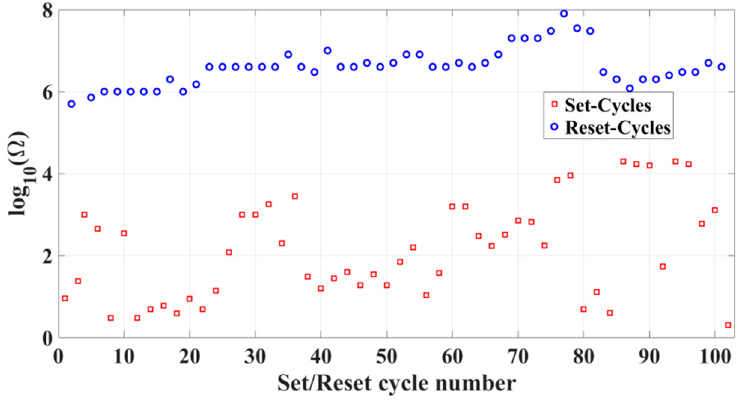
Figure 2. One-hundred switching cycles of a typical MIM cell with Nafion as the ion-conductor.